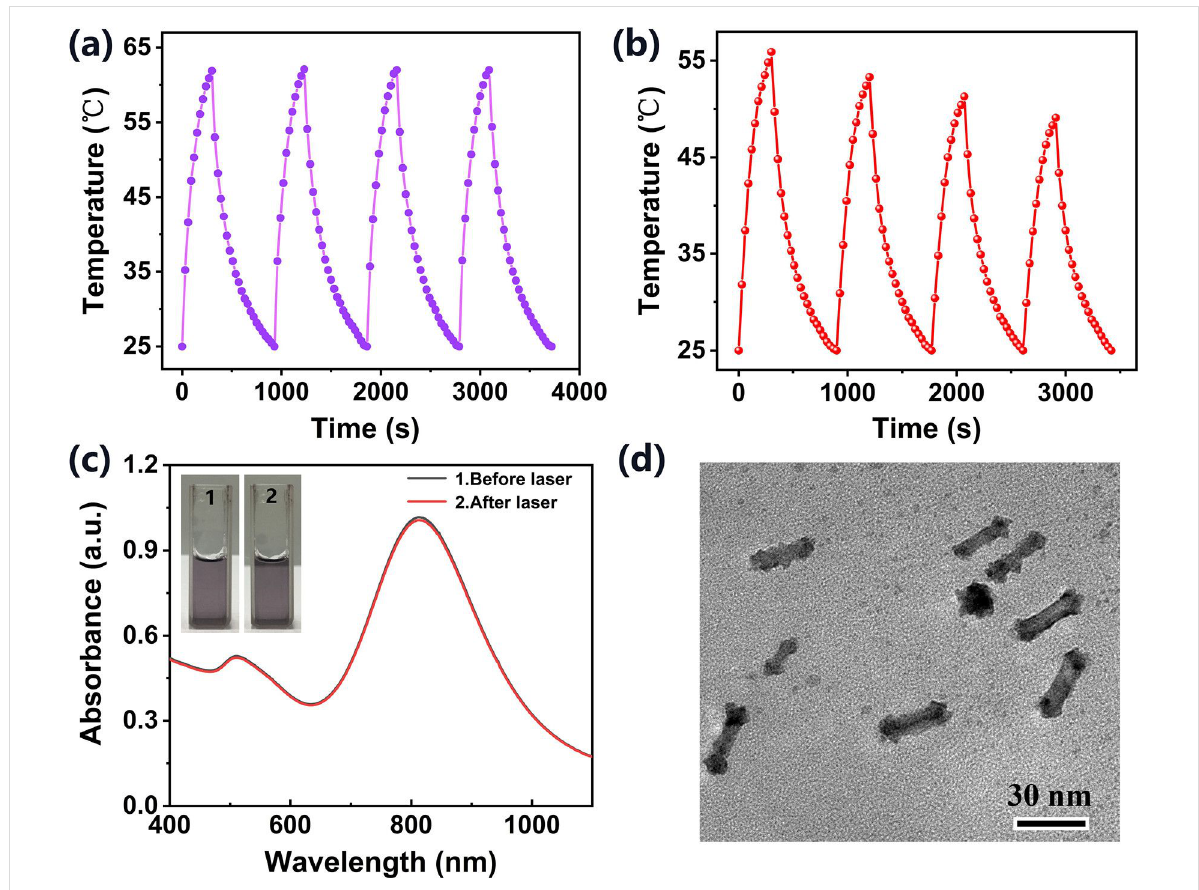
Figure 7: Temperature change curve of (a) Au@Pt NPs solution and (b) AuNRs solution during four on/off cycles of irradiation. (c) Absorption spectra and photographs of Au@Pt NPs solution before and after cycled laser irradiation. (d) TEM image of Au@Pt NPs after cycled laser irradiation.